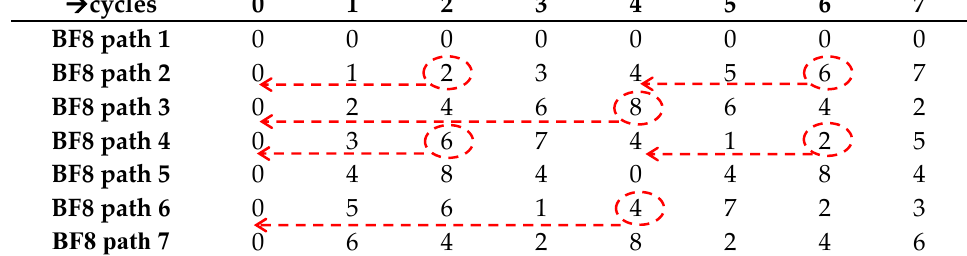
' p W factors (in p ′ ) for each cycle in a given TS. (cid:48) 64 factors (in p (cid:48) ) for each cycle in a given TS. 64